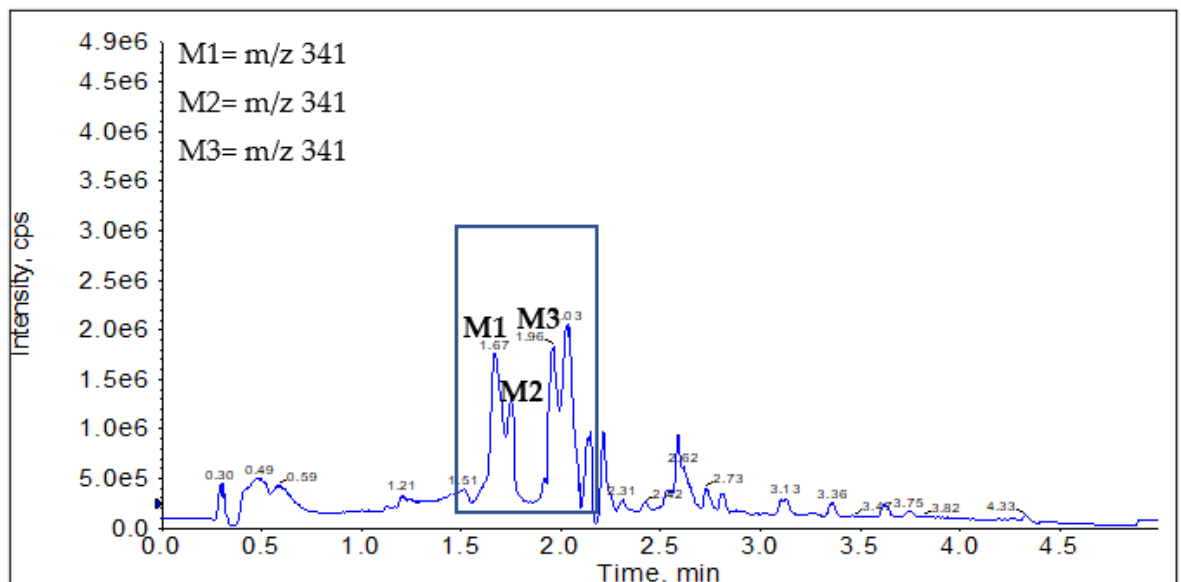
Figure 3. Q1MI chromatogram for m / z 341 obtained from NADPH activated liver microsomes. M1 retention time: 1.67 min; M2 retention time: 1.76 min; M3 retention time: 1.96 min.